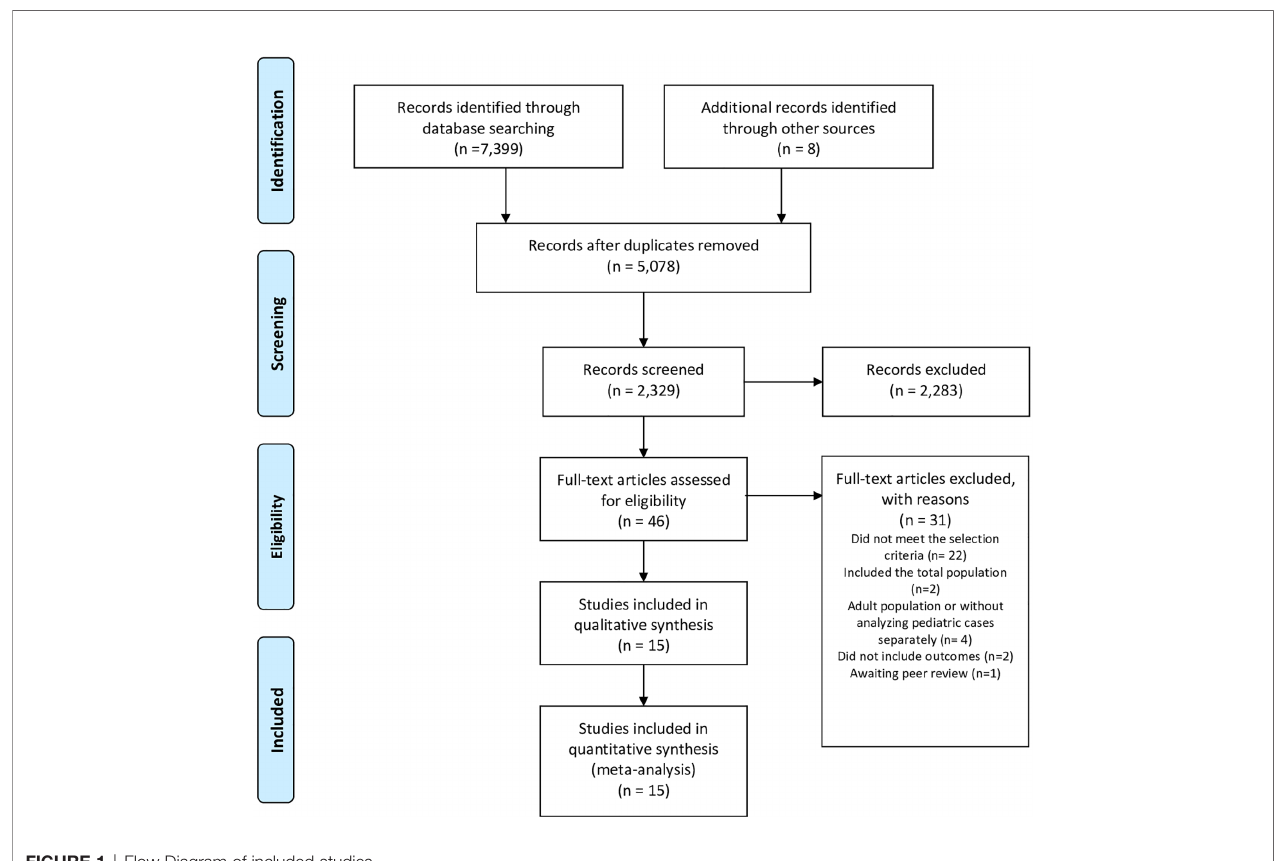
FIGURE 1 | Flow Diagram of included